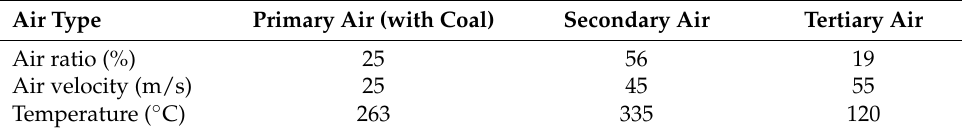
Table 5. Designed parameters of primary, secondary, and tertiary